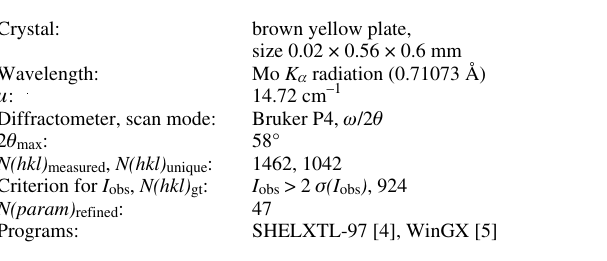
Table 1. Data collection and